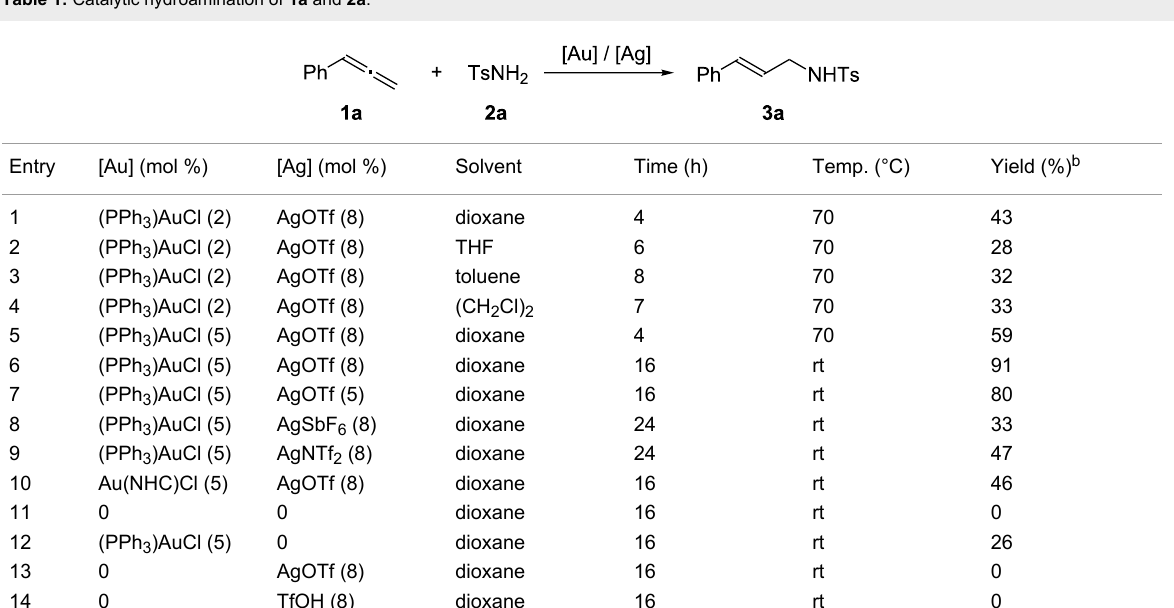
Table 1: Catalytic hydroamination of 1a and 2a .